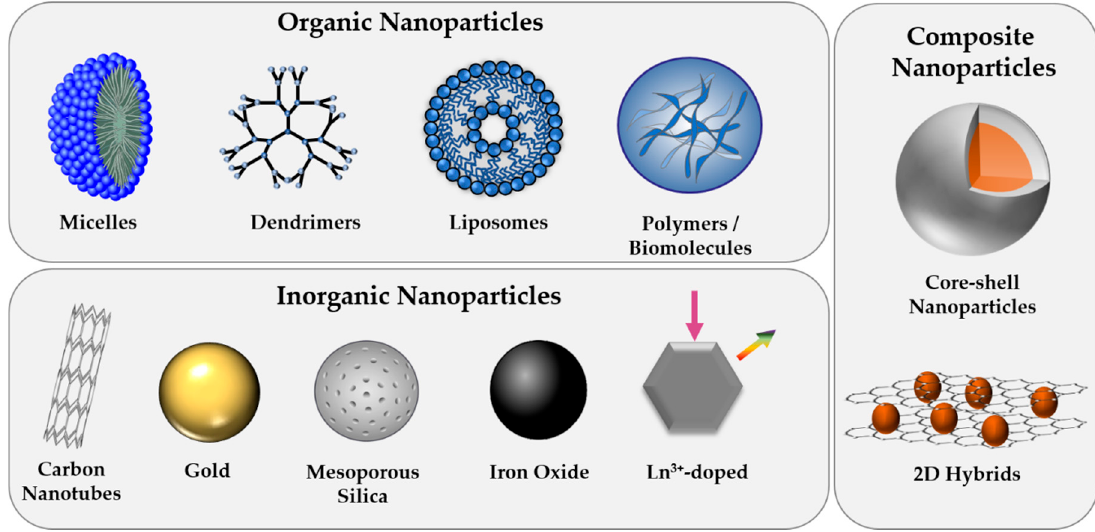
Figure 1. Overview of commonly used nanoparticle (NP) types, classified as organic, inorganic, or composite structures. composite